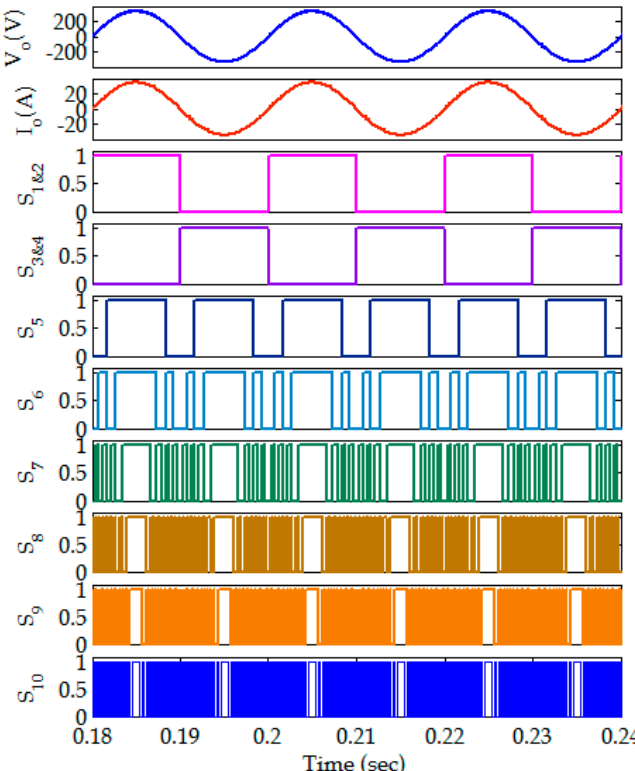
Figure 2. Output waveforms and switching pattern of reduced switch 127 − level multilevel inverter.